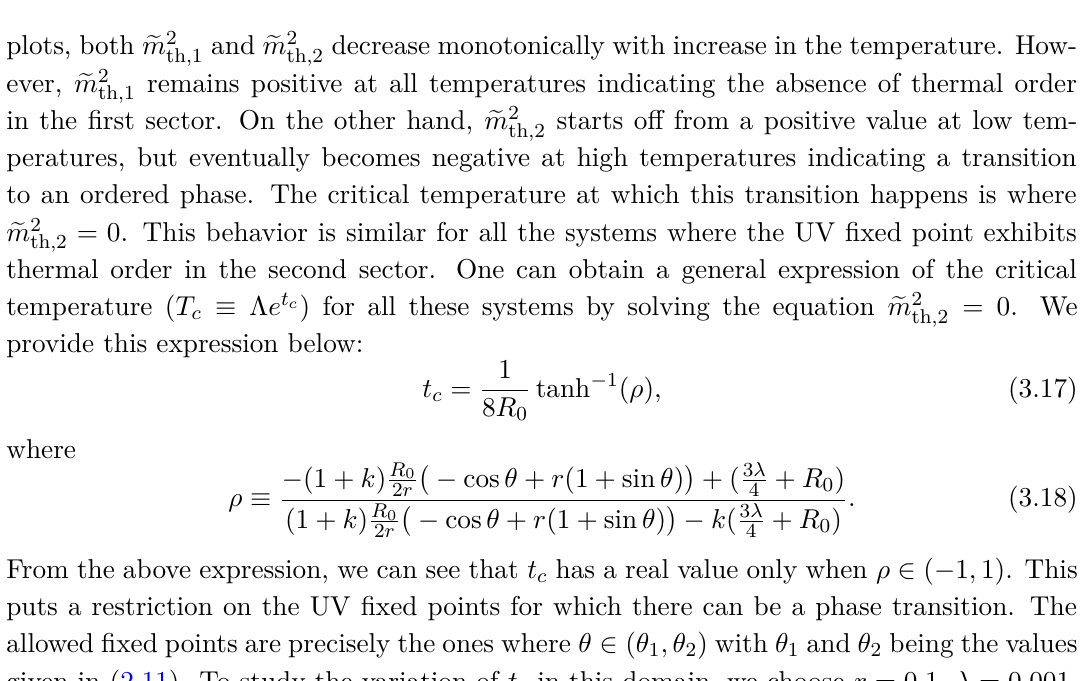
and saturate at positive values. m 2 m 2 e e th , 1 th , 2 saturates at a negative value. m 2 e th , 2 ) is given by t ln( T Λ) ≈ − 1172 . 1 c c ≡ c /